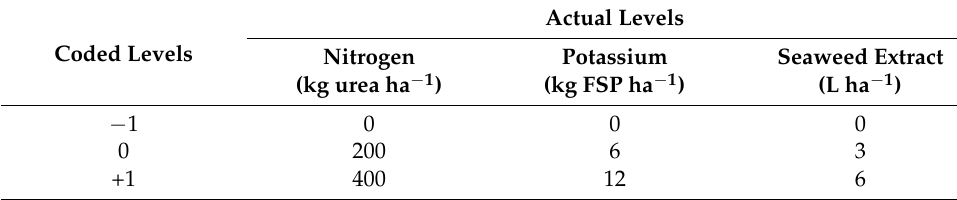
Table 3. Coded and actual levels of the experimental factors.